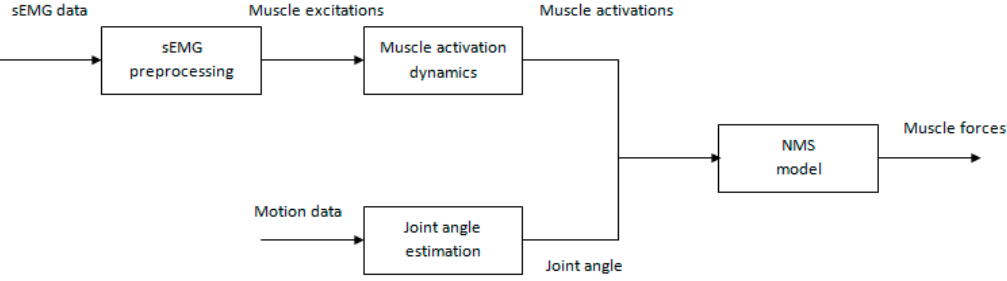
Figure 1. The flowchart of our muscle force prediction method. It consists of four main parts: sEMG preprocessing, muscle activation dynamics, joint angle estimation, and NMS model.